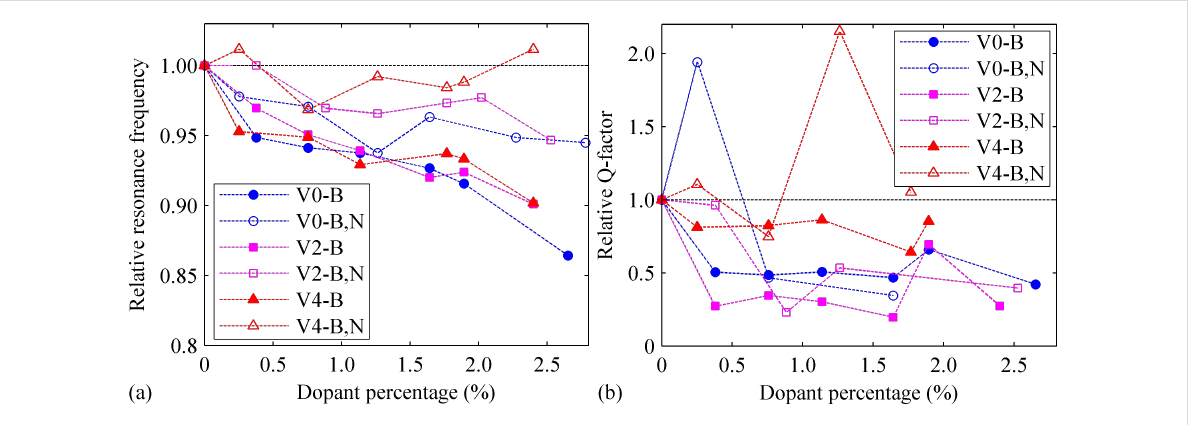
Figure 12: (a) Comparisons of the relative natural frequency among all studied samples. (b) Comparisons of the relative Q factor among all studied samples. V0-B represents the group of a perfect GNR with B-dopant, V0-B,N represents the group of a perfect GNR with both B- and N-dopants; V2-B represents the two vacancies-GNR with B-dopants, V2-B,N represents the two vacancies-GNR with both B-and N-dopants, similar notation is used for the four vacancies-GNR. The normalization was done based on the case with non-dopants atoms in each group.